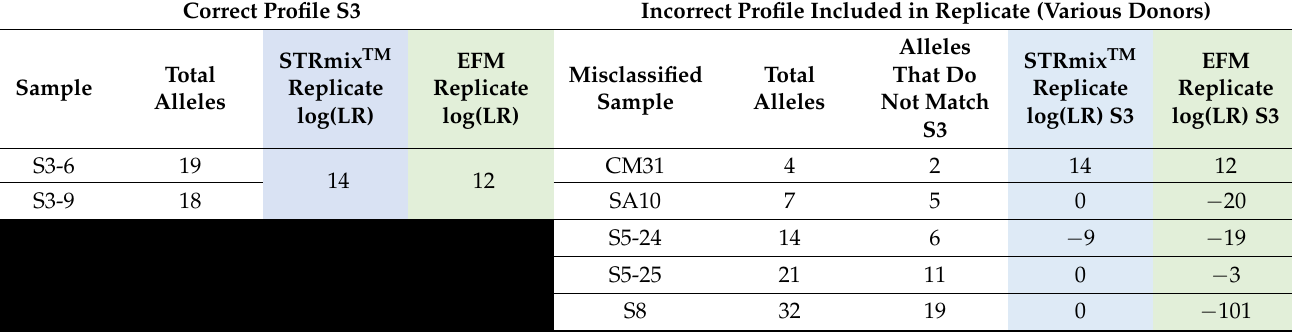
Table 5. Misclassification of single source subsamples for replicate analysis.